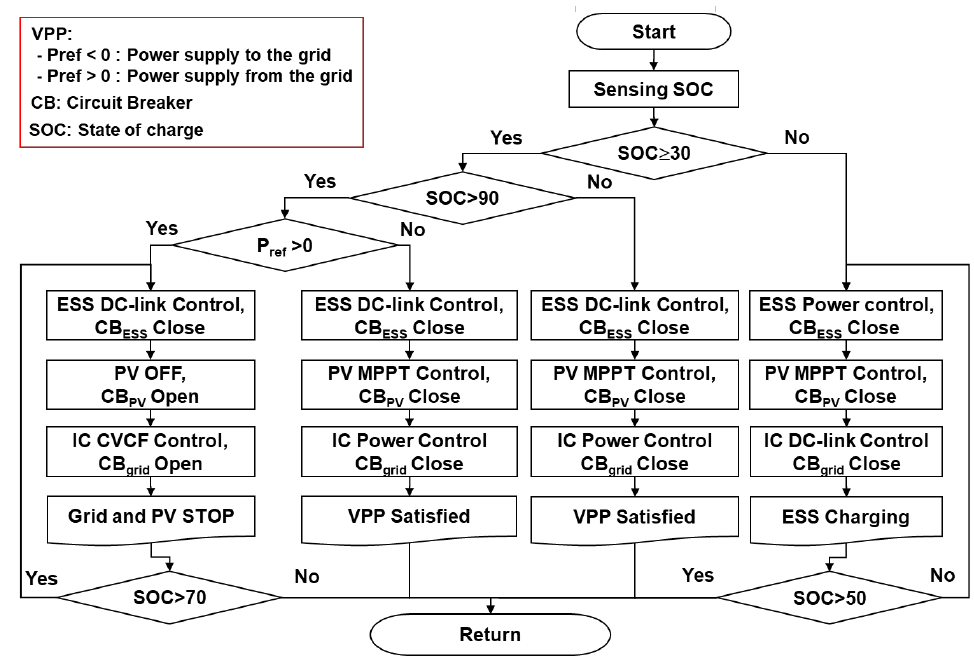
Figure 7. The proposed supervisory power coordination scheme with a VPP request.